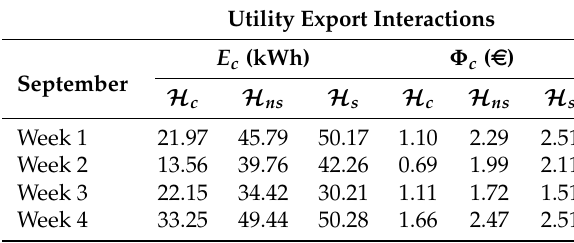
Table 4. Summary of energy interactions with the utility (compensated energy).